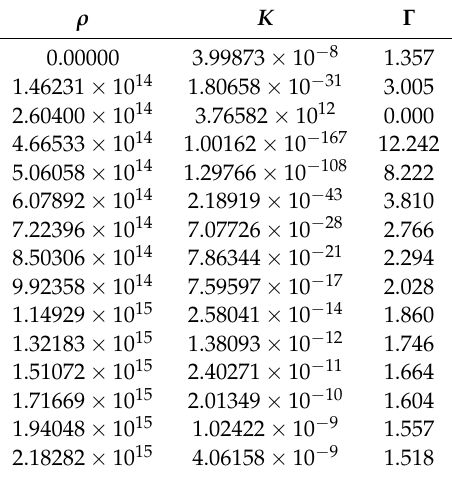
Table A1. Piecewise polytrope of the HyS EoS used in the simulations. The units are chosen so that the rest-mass density ρ is in g/cm 3 , Γ is dimensionless and K is such that the pressure p is in g/cm 3 . The i -th row refers to the polytrope p = K i ρ Γ i , for ρ i ≤ ρ ≤ ρ i + 1